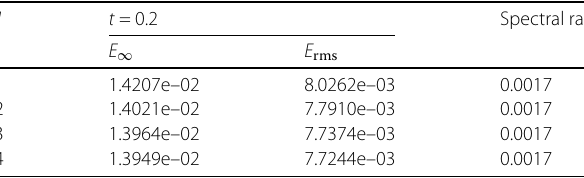
Table 4 Error norms of Example 5.2 at γ = 0.9, θ = 1